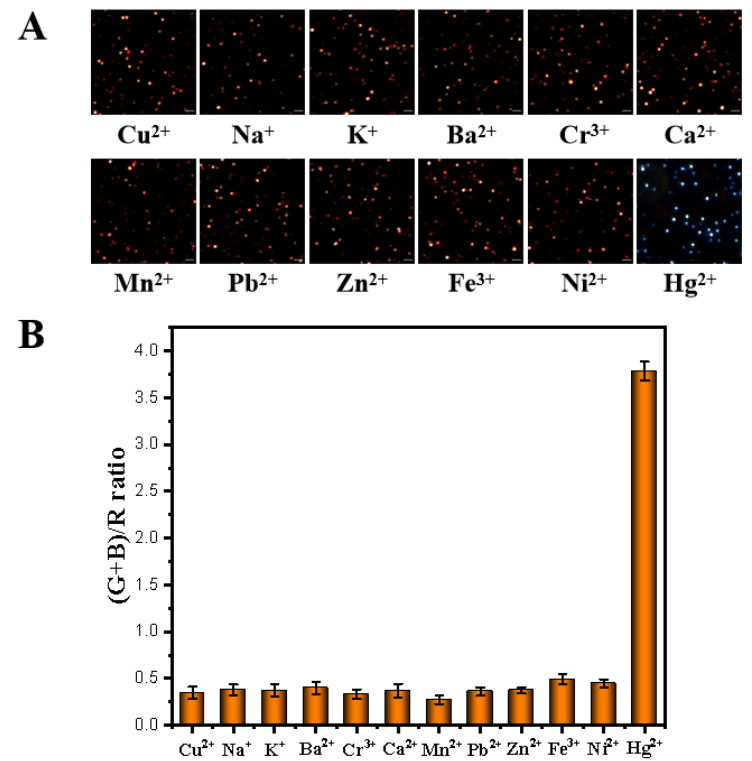
Figure 6. The response of concave cube Au nanoparticles to Hg 2+ in the case of comparative other metal ion, including Cu 2+ , Na + , K + , Ba 2+ , Cr 3+ , Ca 2+ , Mn 2+ , Pb 2+ , and Zn 2+ . ( A ) Representative DFM images. ( B ) The histogram of (G+B)/R ratio.